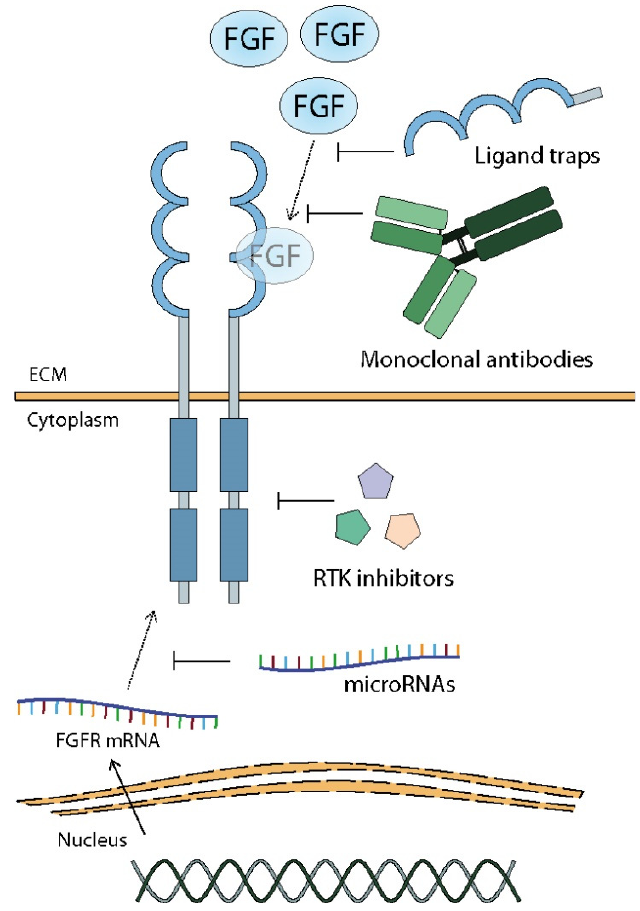
Figure 4. Anti-cancer therapy strategies based on targeting of FGF/FGFR. Ligand traps are fusion molecules that prevent FGF binding and subsequent receptor dimerization. Monoclonal antibodies neutralize specific members of the FGF family members. Chemical receptor tyrosine kinase inhibitors (TKi) are able to inhibit FGFR activation and phosphorylation. Finally, microRNA molecules are capable of silencing both oncogenes and tumor suppressors. Targeting the FGF/FGFR axis with these agents may hold promise for anti-cancer treatment, including overcoming